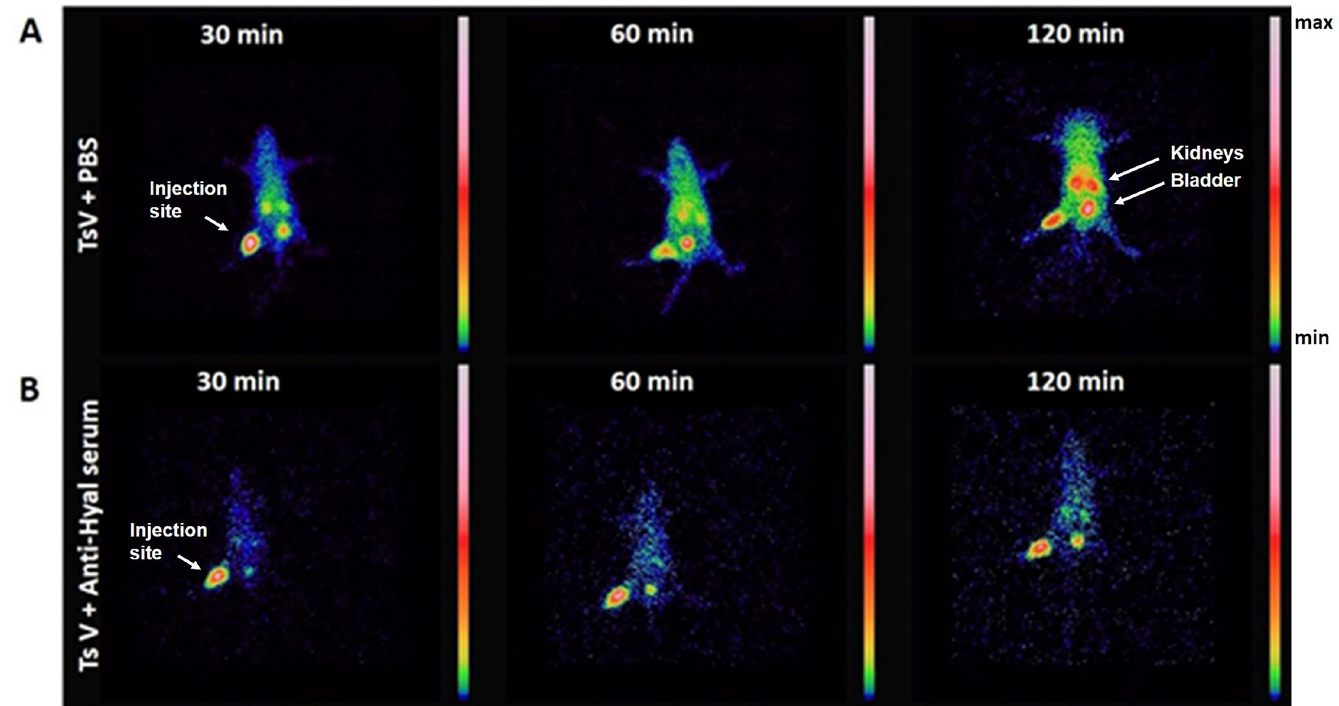
Fig 4. 99m Tc-TsV spreading in mice over time. Representative scintigraphic images of mice injected with 18 MBq 99m Tc-TsV diluted in PBS (A) or neutralized with anti-hyaluronidase serum (B). Samples were intravenously injected in Swiss mice (6–8 weeks old, 24–28 g; n = 3 per group). Radioactivity levels were measured 30, 60, and 120 min post-injection. Images show a quick and growing spread of 99m Tc-TsV diluted in PBS over time (A). On the other hand, TsV neutralized with anti- hyaluronidase serum remains at the injection site (right tight muscle) (B). Images are pseudocolored according to the color scale.